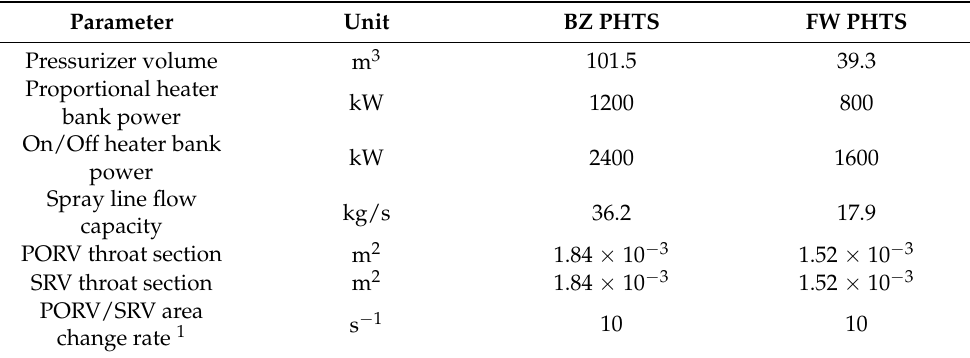
Table 2. BZ and FW PHTS pressurizer system